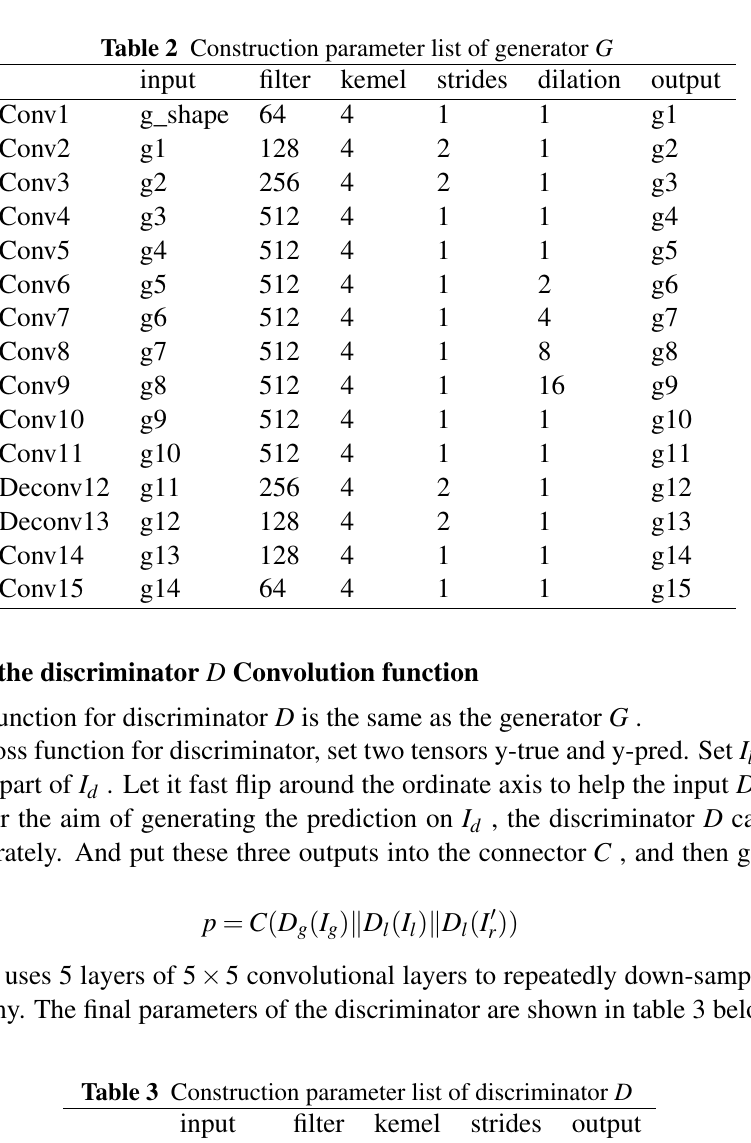
Fig. 6 The setting of deconvolution layers